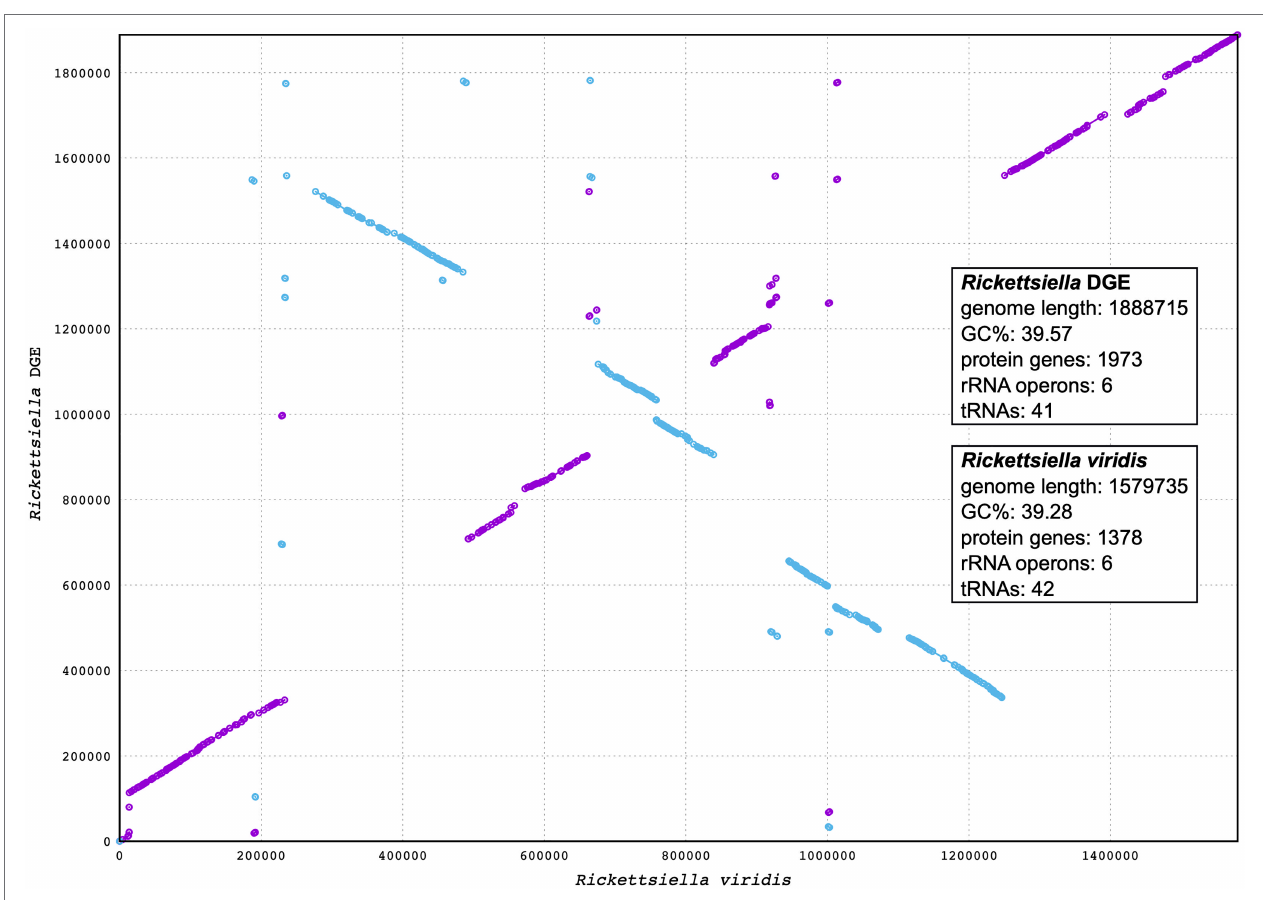
FIGURE 5 | Synteny analysis between Rickettsiella DGE and Rickettsiella viridis genomes. The Rickettsiella DGE genome is represented on the y axis and the R. viridis genome is represented on the x axis. Blue and purple lines represent synteny between the two genomes, with blue lines being inverted in Rickettsiella DGE relative to R. viridis